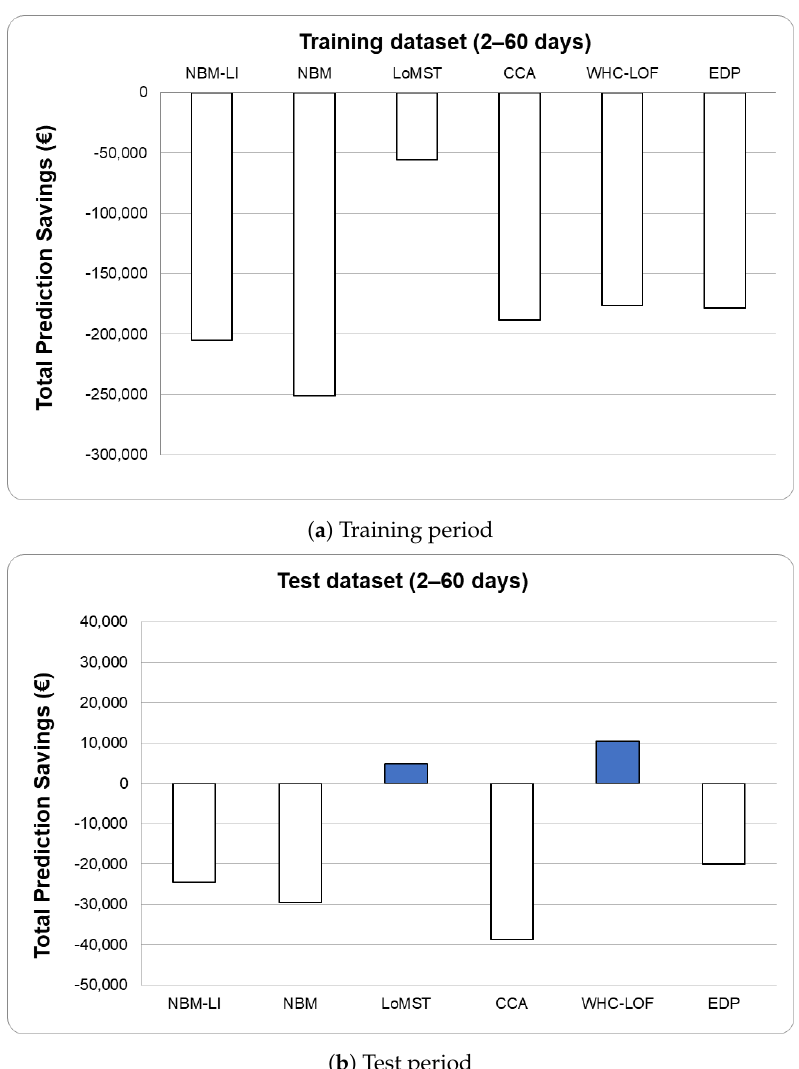
Figure 13. Total Prediction Savings (TPS) for each model, EDP evaluation method (2–60